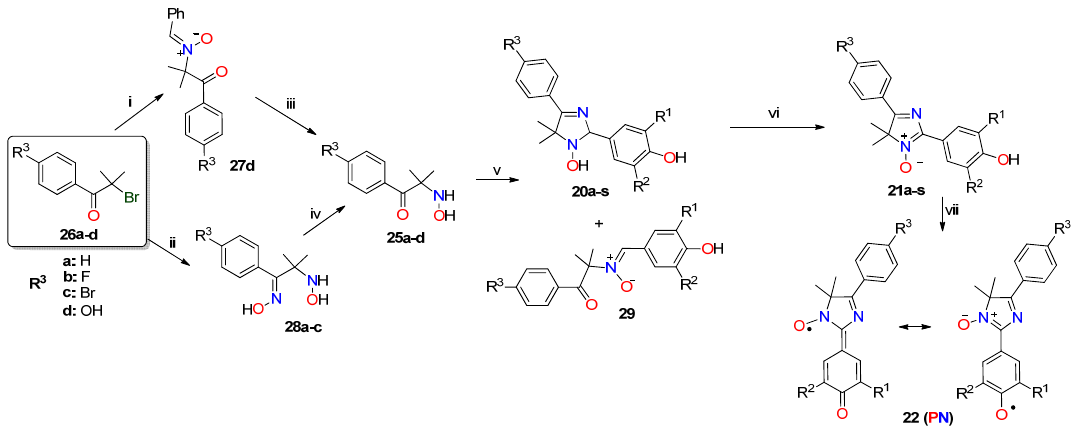
Scheme 5. Synthesis of key compounds: 2,4-diaryl-1-hydroxy-2,5-dihydroimidazoles 20 , 2,5-diaryl-4 H -